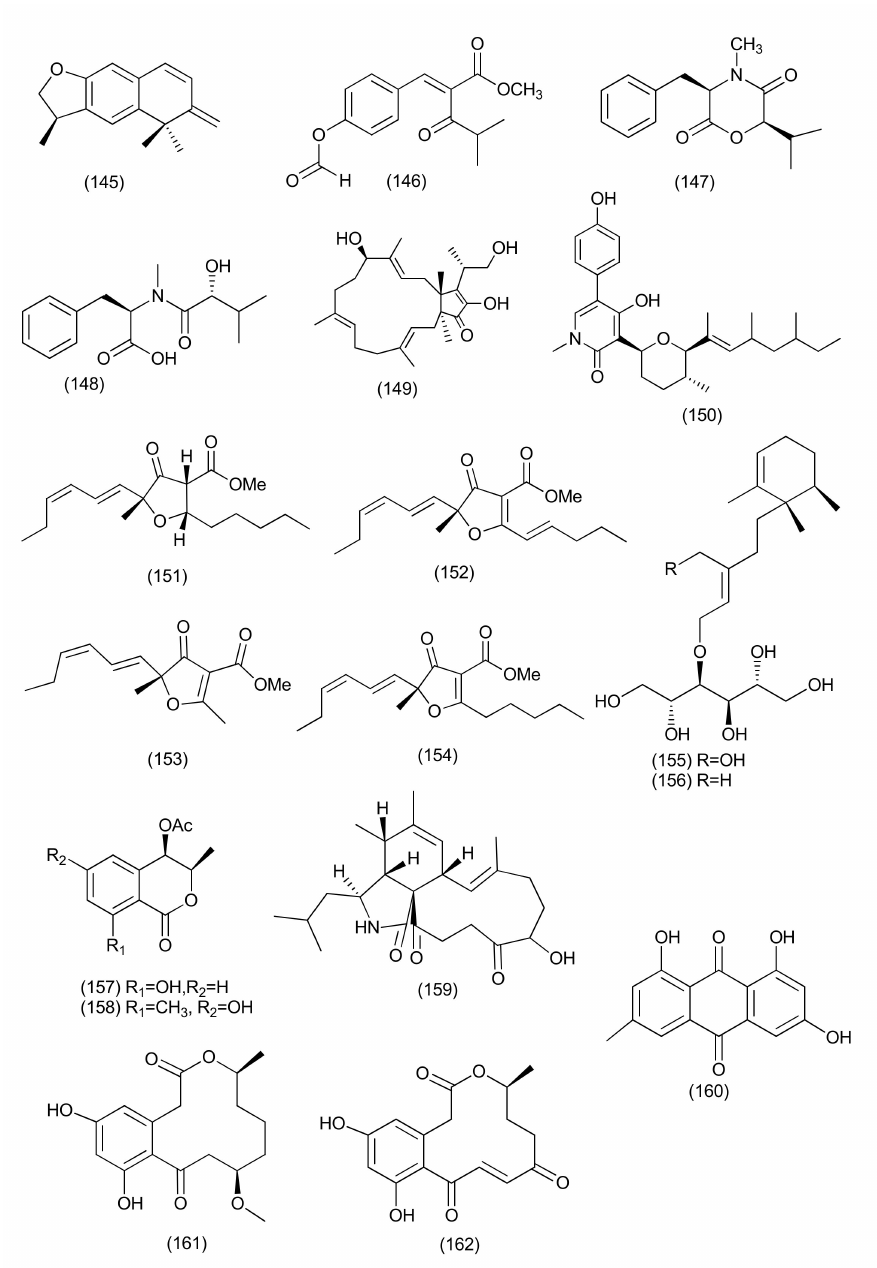
Figure 9. Structures of metabolites 145 – 158 and 159 – 162 isolated from Ascomycetes and Anamorphic Ascomycetes,